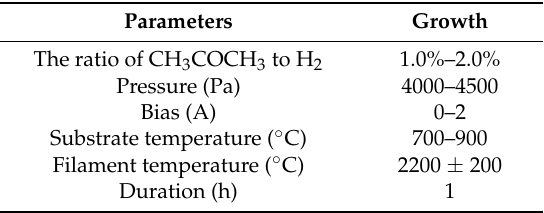
Table 1. Deposition parameters of CVD microcrystalline diamonds fabricated with the seeding method by HFCVD.